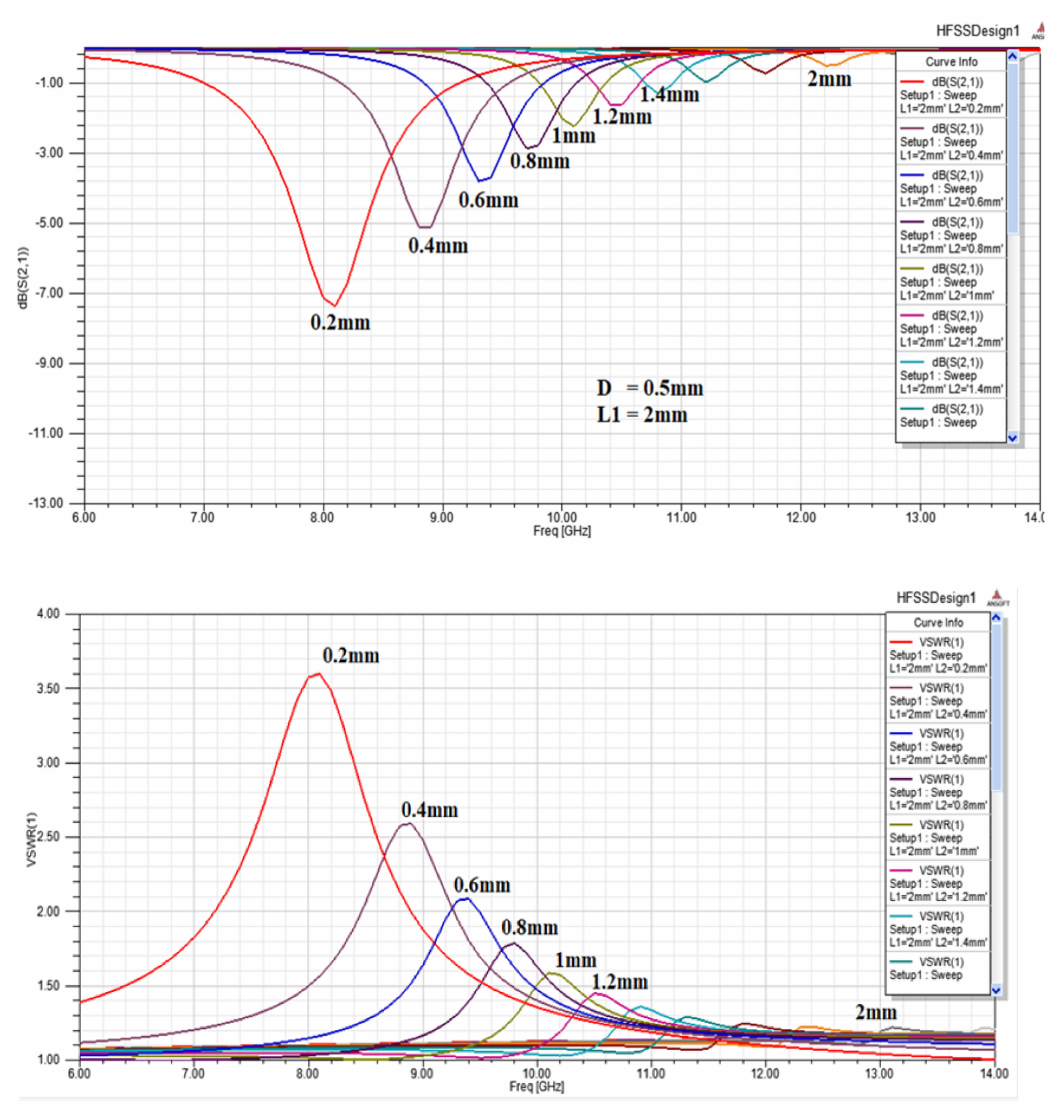
Figure 14. Transmission and VSWR curves vs. frequency with the probe coupling as a parameter. If the absorbent disc was positioned at the point where the intensity of the magnetic field was greater than the strength of the electric field, the resonant frequency decreased to a lower value; therefore, keeping its position constant avoids a further adjustment